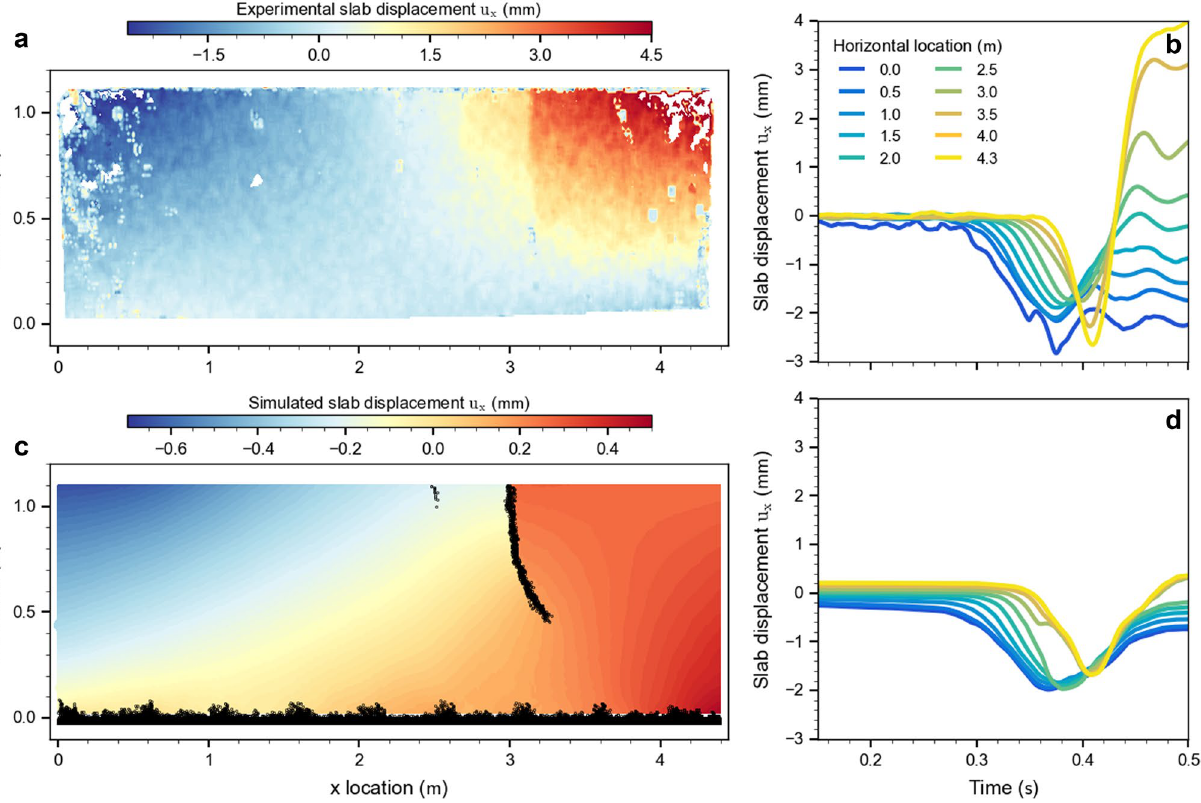
Figure 6. ( a ) Experimental and ( c ) simulated slab horizontal displacement field at the end of the experiment. Black dots in ( c ) indicate the positions of broken bonds and show the slab fracture. ( b ) Experimental and ( d ) simulated temporal evolution of subsets of tangential displacements located at the top of the beam; colors indicate horizontal location along the beam.